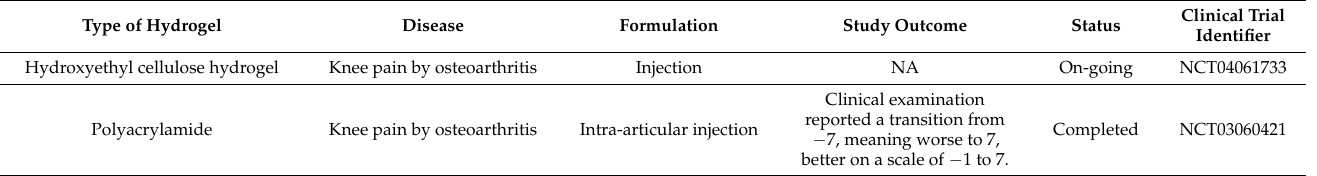
Table 3. List of Clinical trials relating to various biomedical applications of